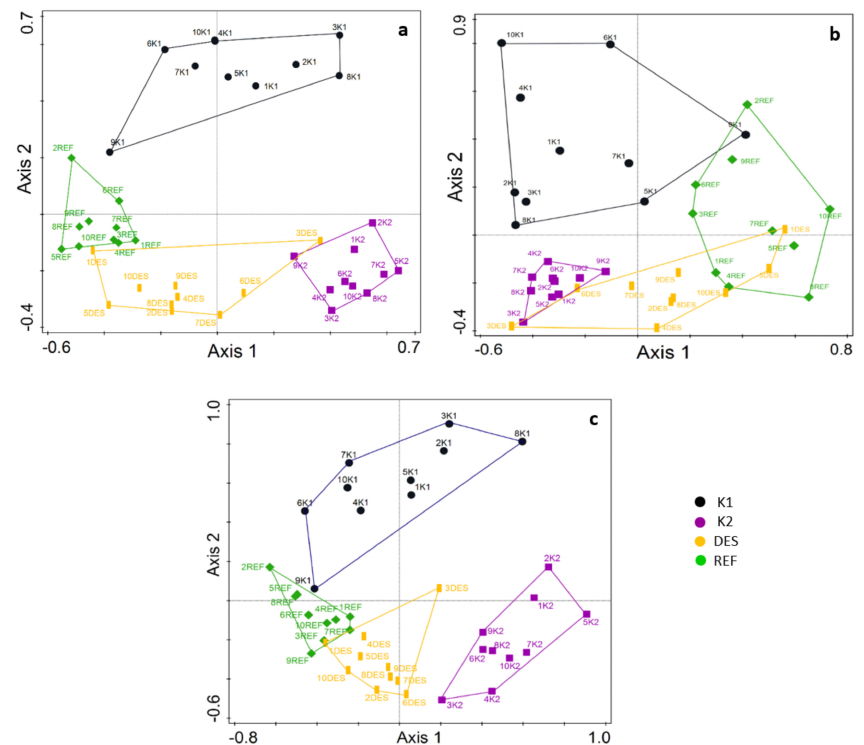
Figure 5. Principal component analysis (PCA) summarizing variation in the fungal community based on the number of sequences from 10 microsites per forest that is attacked by bark beetle (K1), destroyed by bark beetle (K2), with removed trees (DES), and mature (REF): ( a ) fungal sequence abundances; ( b ) ECM fungal sequence abundances; c ) saprotroph sequence abundances.